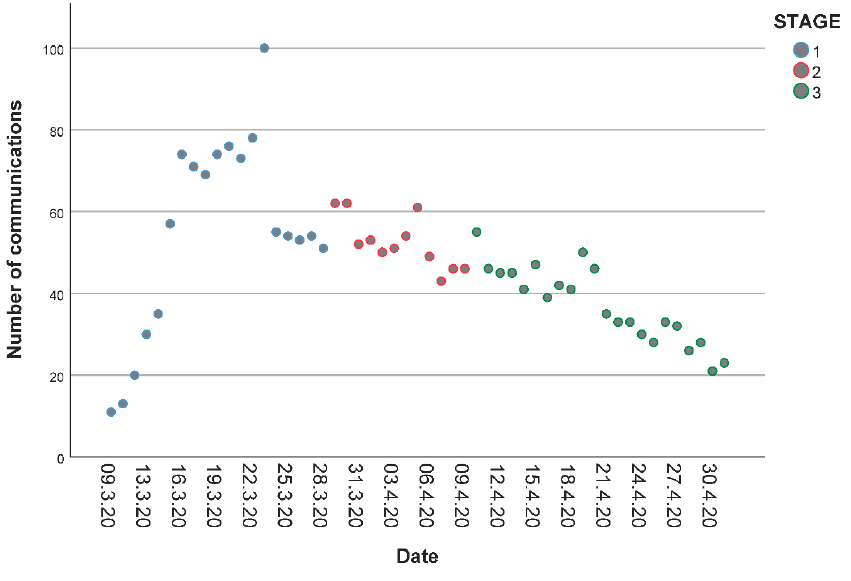
Figure 1. Normalized ratio of communications per day, grouped by stage.